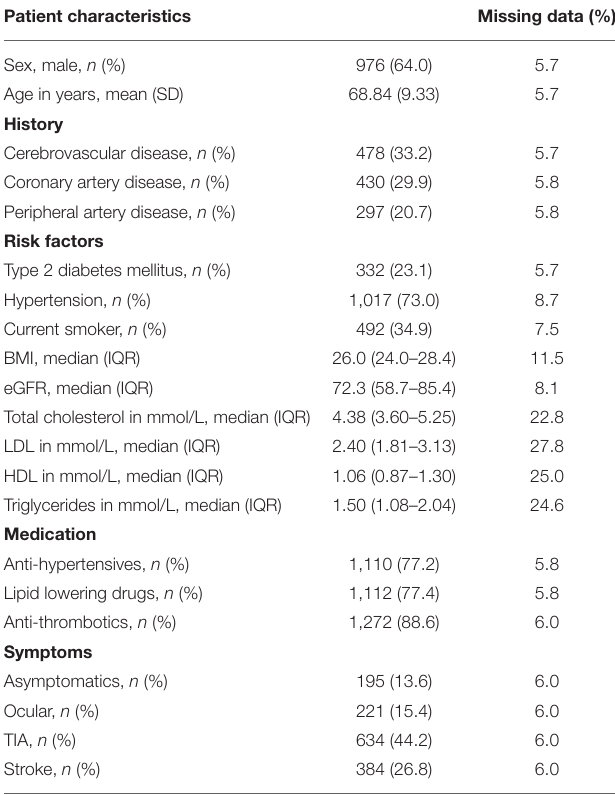
TABLE 1 | Baseline characteristics of genotyped CEA patients from the Athero-Express Biobank